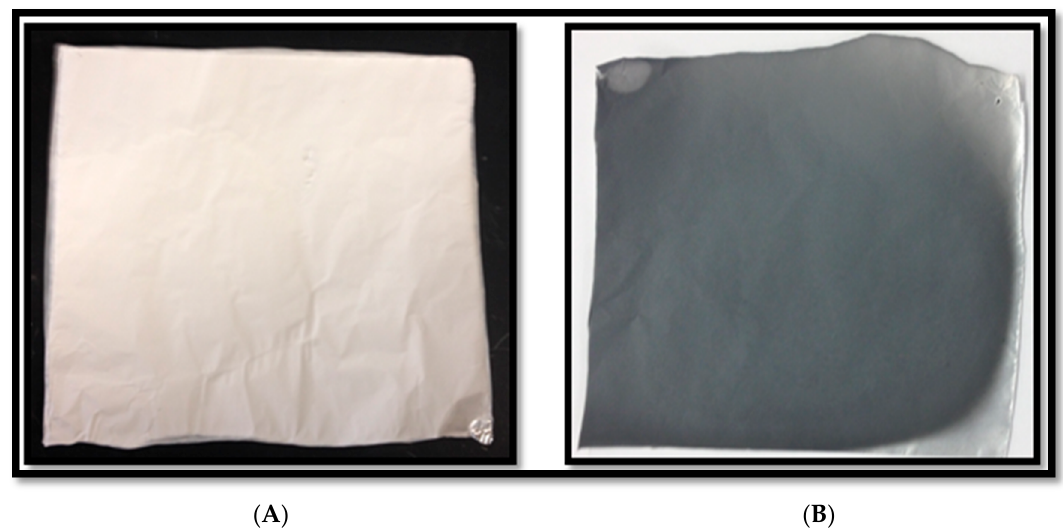
Figure 1. Polyvinylidene fluoride-co-hexafluoropropylene (PVDF-HFP) electrospun fiber mat ( A ) without and ( B ) with catalytic nanoparticles.